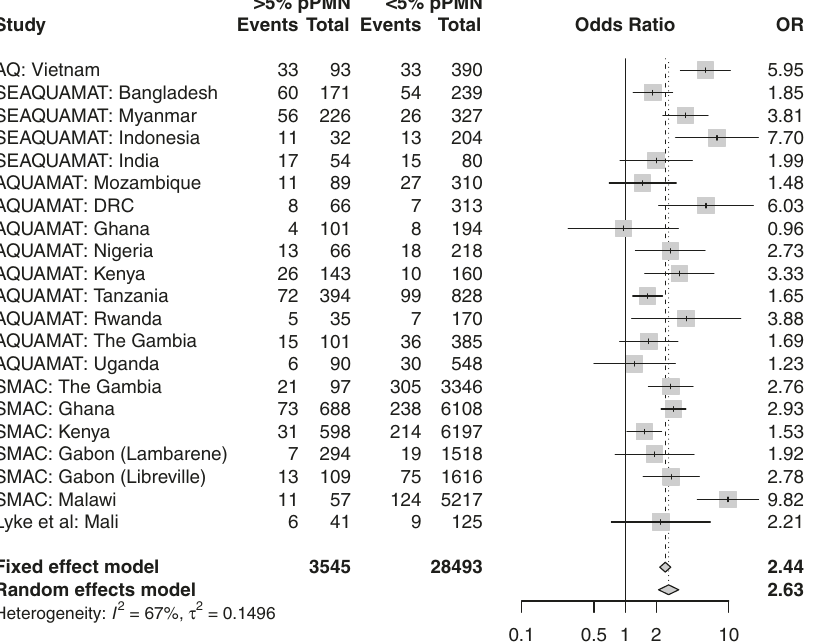
(horizontal lines) are shown for each study broken down by country of enrolment except for SMAC, Gabon where the distribution of pigment-containing PMNs was substantially different between the two sites (Lambaréné and